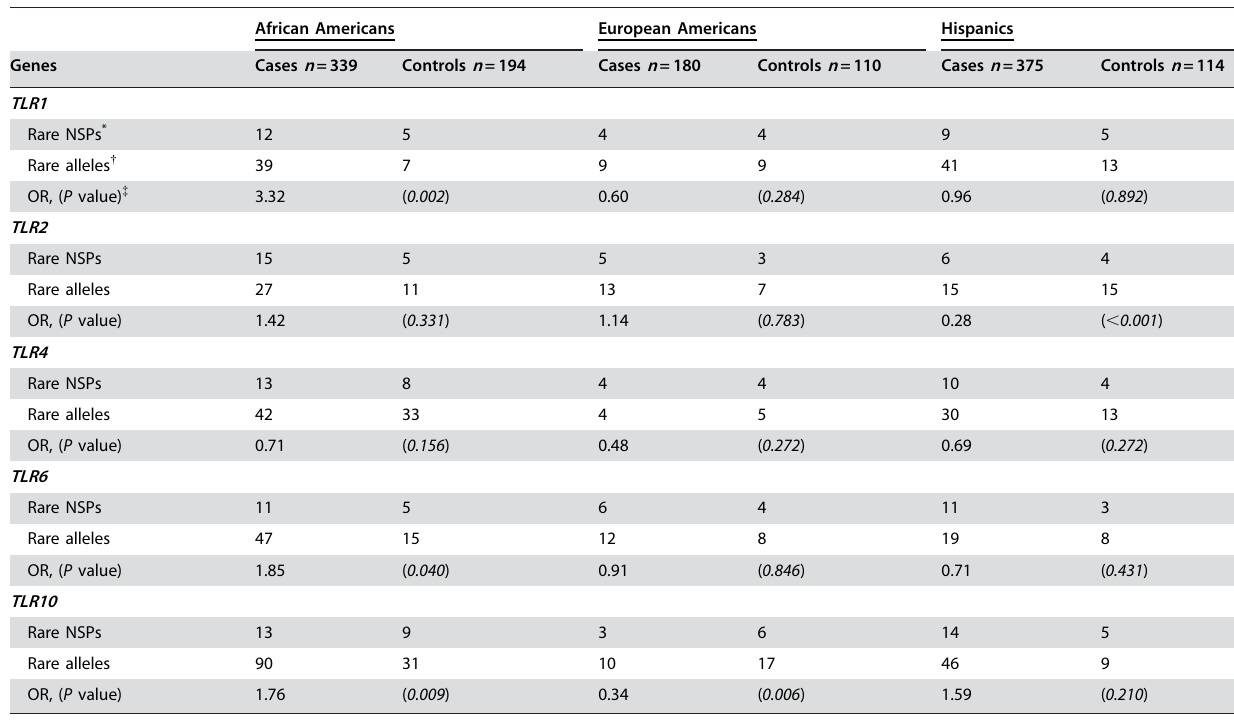
Table 2. Association between rare NSPs of TLR1, 2, 4, 6, 10 and TB disease .. ... .... ... ... .... ... ... .... ... ... .... ... ... .... ... ... .... ... ... .... ... ... .... ... ... .... ... ... .... ... ... .... ... ... .... ... ... .... ... ... .... ... ...